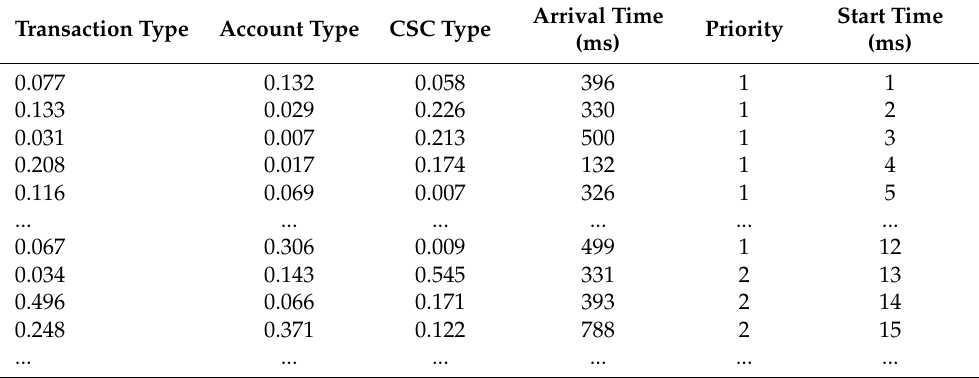
Figure 15. Compressing training set learning curve scatter diagram. Table 9. Transactions with priority and new start time.